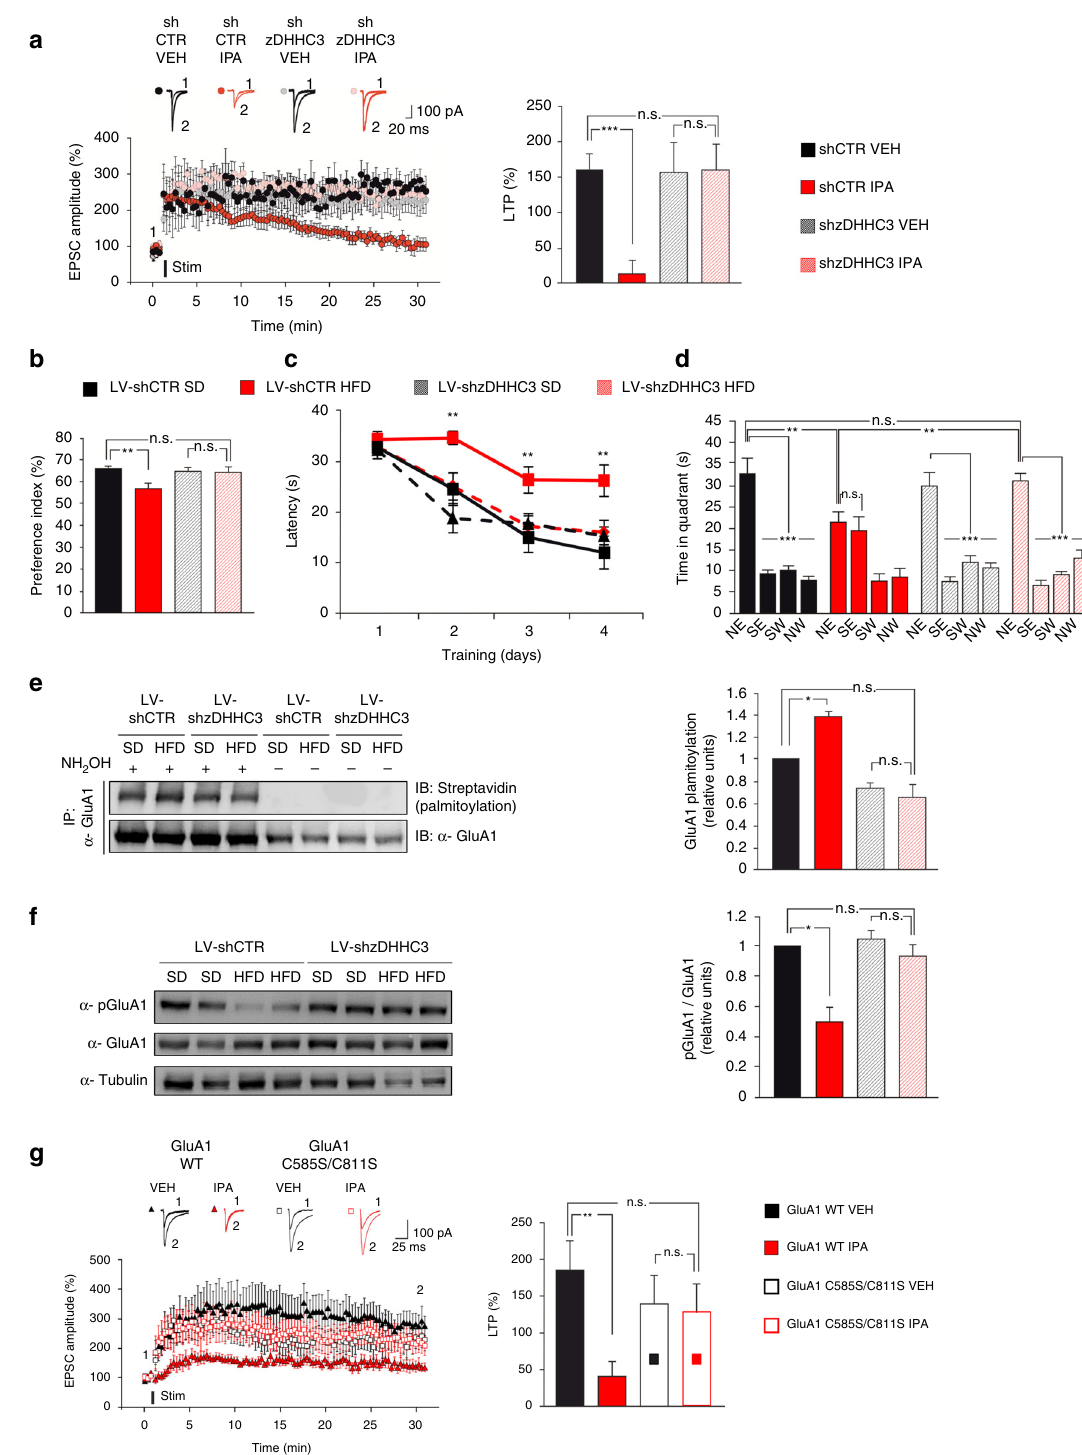
hypo-phosphorylation ( − 49.6%; F 3.49 = 8.55, LV-shCTR SD vs. LV- than LV-shCTR mice fed HFD (time in the target quadrant: F 3.008 = 4.87, LV-shCTR SD vs. LV-shCTR HFD p = 0.004; LV- shCTR HFD p = 0.016; Fig. 5f) of AMPA receptor subunit in the shCTR SD vs. LV-shzDHHC3 HFD p = 0.61; LV-shzDHHC3 HFD hippocampi of HFD mice. Moreover, biolistic overexpression of vs. LV-shCTR HFD p = 0.003; time spent in the 4 quadrants: F 3.008 palmitoylation-de fi cient GluA1 (GluA1 C585S/C811S), but not = 7.59 for LV-shCTR = 0.83; Fig. 5d). Notably, GluA1 wild type (WT), abolished the impairment of LTP induced HFD , NE vs. SE p zDHHC3 silencing also abolished both the hyper-palmitoylation by IPA in organotypic slices (F 2.89 = 3.128, GluA1 WT VEH vs. (+ 39.7%; F 4.75 = 13.64, LV-shCTR SD vs. LV-shCTR HFD p = 0.013; GluA1 WT IPA p = 0.004; Fig. 5g). Collectively, our fi ndings point LV-shCTR SD vs. LV-shzDHHC3 HFD p = 0.11; Fig. 5e) and the to the key role of both zDHHC3 overexpression and